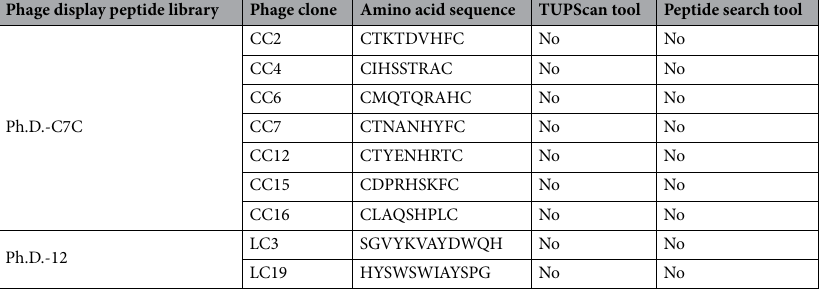
Table 2. Bioinformatics analysis of identified peptides obtain from phage display. TUPScan tool (http://i. uestc. edu. cn/ sarot up3/ cgi- bin/ TUPSc an. pl): a tool of the SAROTUP web server for the prediction of TUPs based on the match with any known TUP motif. Peptide search tool (https:// www. unipr ot. org/ pepti desea rch/): a tool for the scan of peptides that match with sequences deposited in the UniProtKB database. CC – phage clone carrying 7-mer cyclic peptide; LC – phage clone carrying 12-mer linear